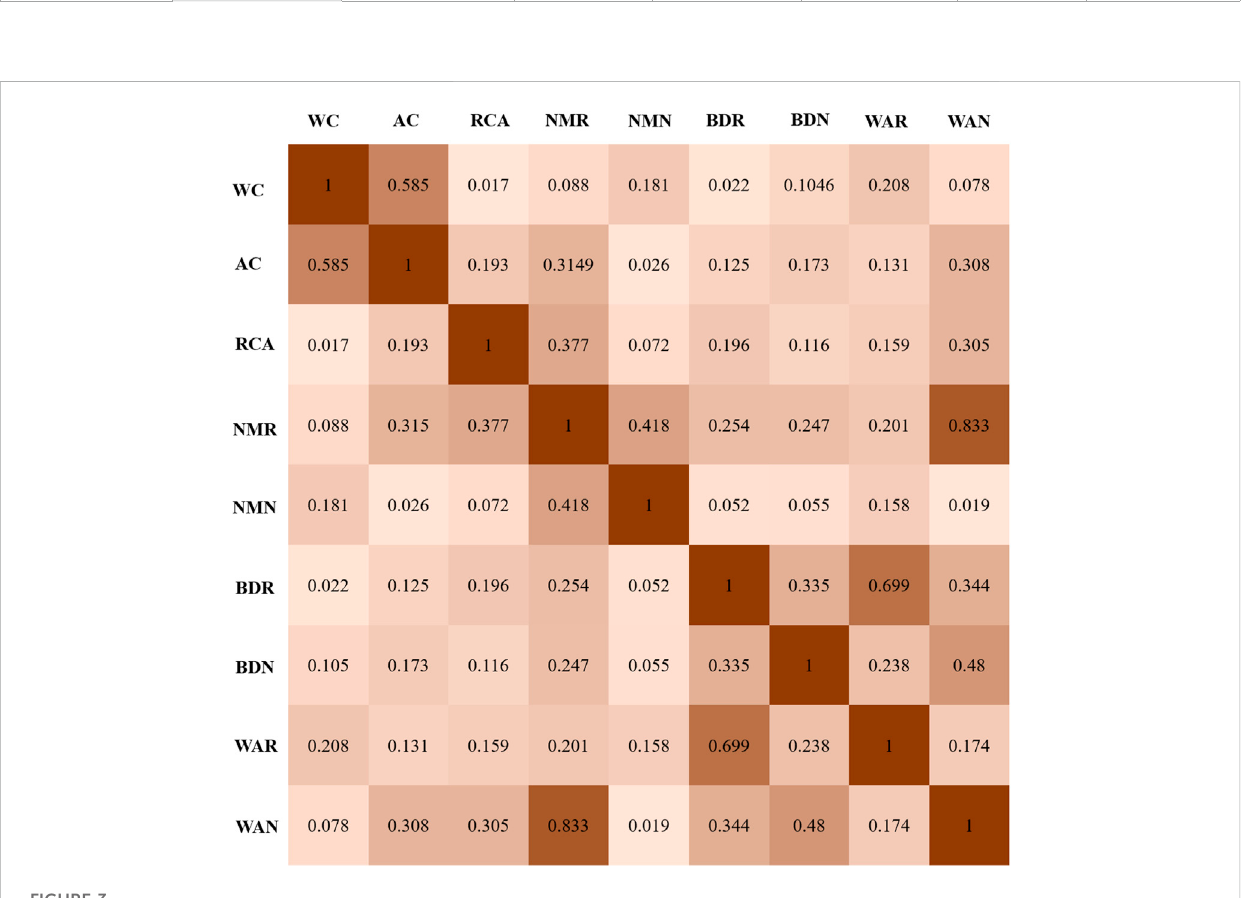
FIGURE 3 The correlation analysis of input